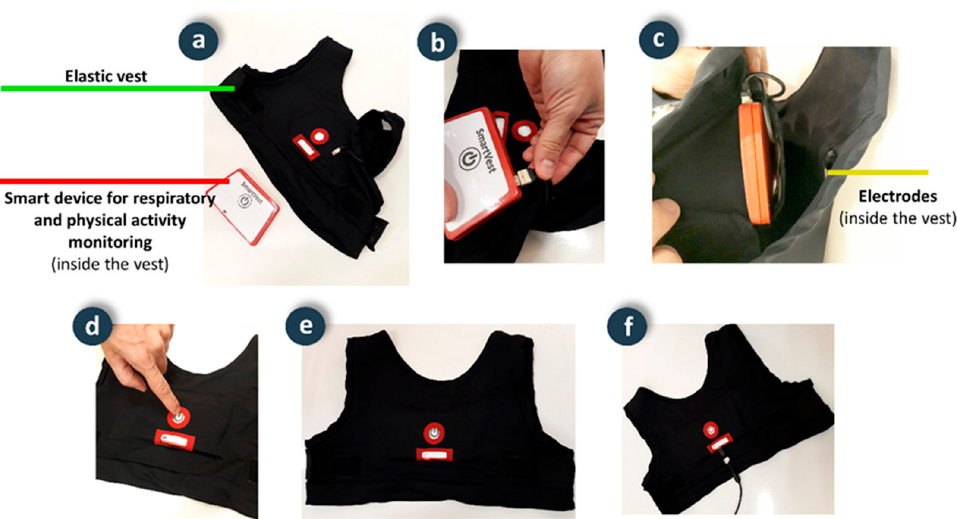
Figure 5. Smart vest: ( a ) Components; ( b ) Device connection; ( c ) Smart vest interior detail; ( d ) Push button power on detail; ( e ) Detail of the indicator led; ( f ) Detail of the charging process.